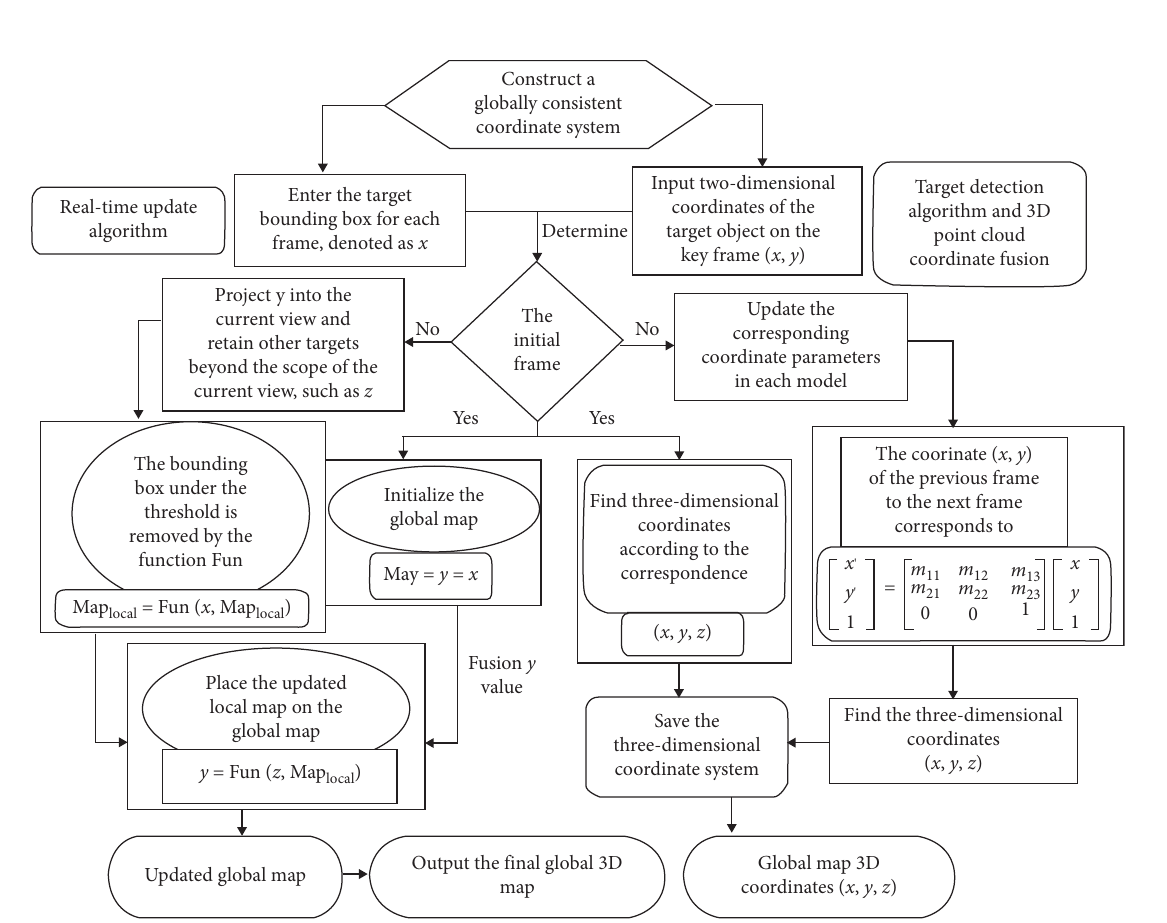
Figure 4: Flowchart for construction of semantic